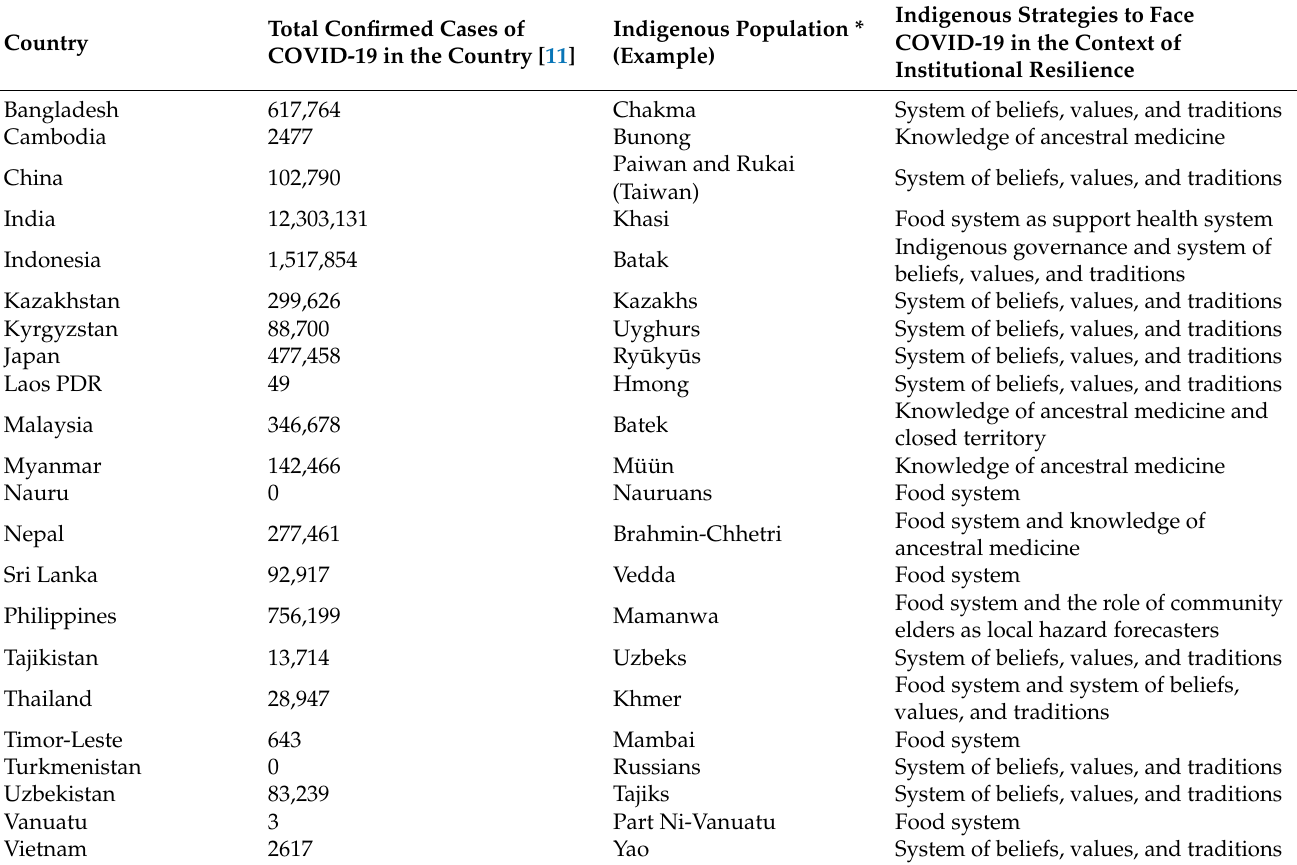
Table 3. Asian countries with indigenous populations and their strategies deployed in the face of COVID-19.